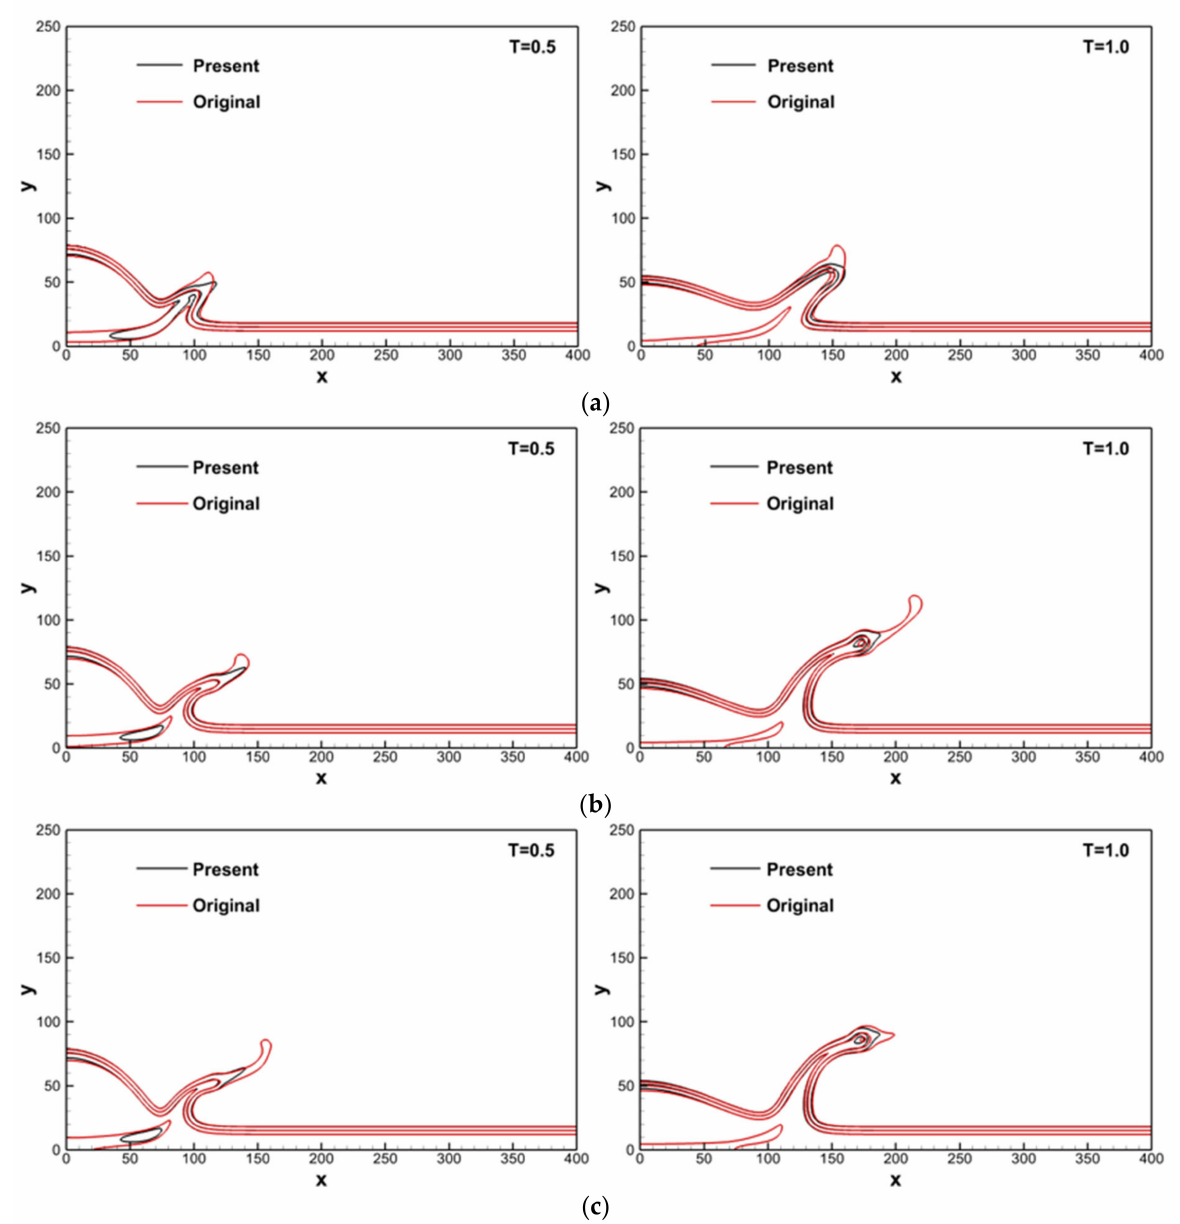
Figure 21. Comparison of the interface shapes of different Reynolds number with two methods; the three contour lines from up to down: 0.05, 0.5, 0.95. ( a ) Re = 100, ( b ) Re = 800, ( c ) Re =